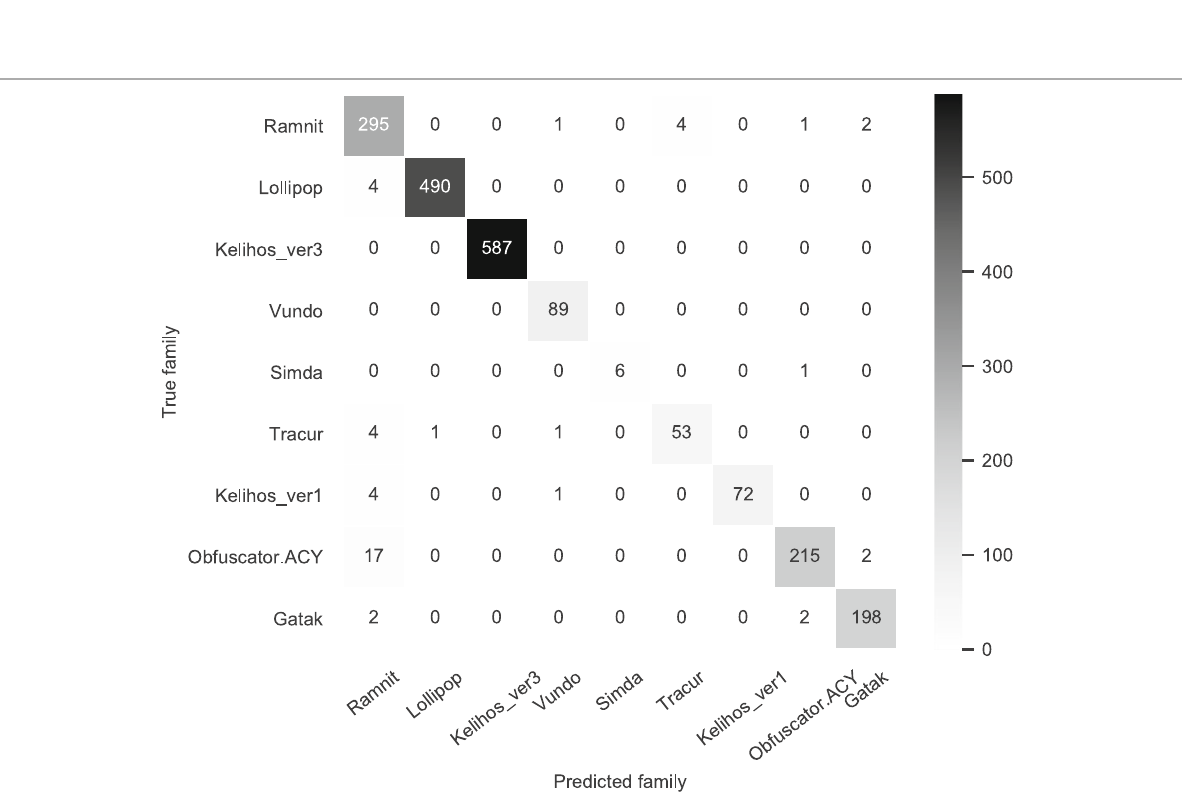
Fig. 12 Confusion matrix for malware categorization with the Word2Vec-based TCN